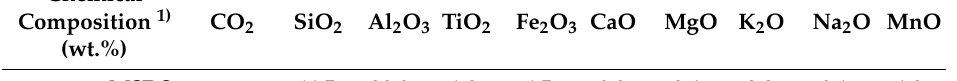
Table 2. Chemical composition of ceramics used.